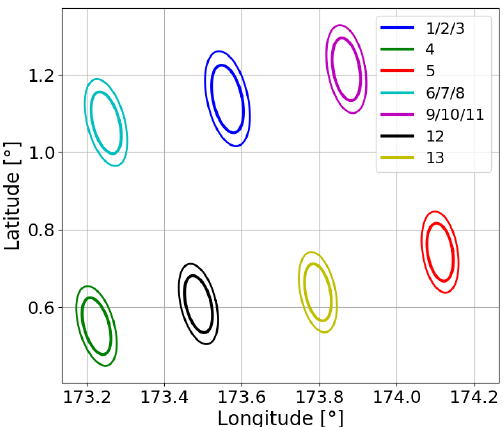
Figure 2. Instantaneous ICI footprints. The inner and outer contours represent the − 3 and − 6dB level of normalised antenna patterns. The assumed sensor position is 6.9 ◦ S, 175.3 ◦ E at an altitude of